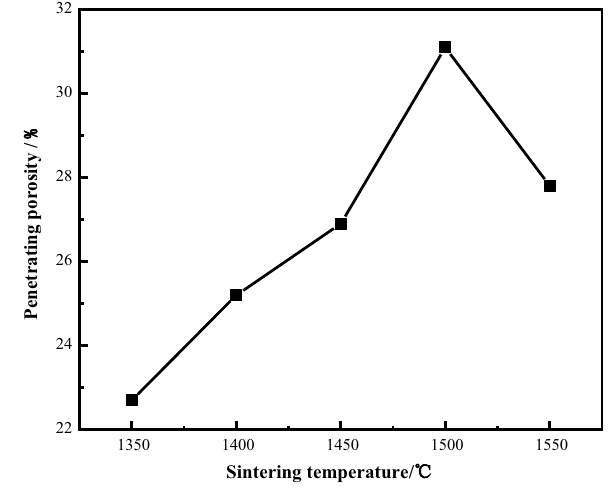
Fig.9 Penetrating porosity of samples sintered at various tempera- tures for 2 h in the